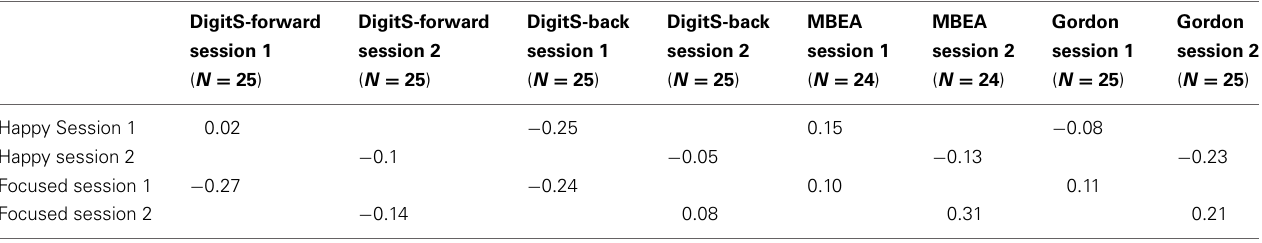
Table 6A | Spearman’s rank-order correlations between verbal and music memory tests and scores on scales of Happy and Focused in Group PV (first session = placebo, second session = vasopressin).